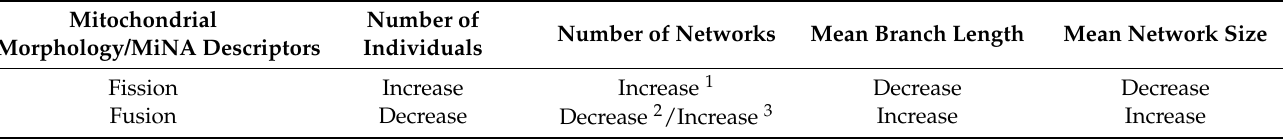
Figure 1. Mitochondrial morphology descriptors. The mitochondria morphology is classified as individuals or networks. Individuals consist of structures without a junction pixel, while networks contain branches with one or more junction pixels. Scale bar = 100 µ m. Table 1. Mitochondrial morphology predictions with MiNA descriptors. Mitochondrial fission and fusion cause changes to mitochondrial morphology. The most predominant process dictates mitochondrial morphology and can provide an insight into mitochondrial